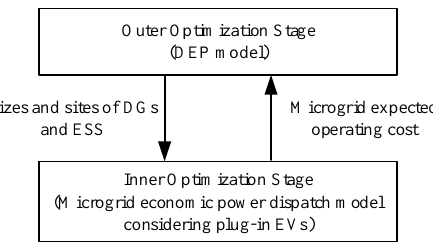
Figure 1. Two-stage modeling framework of the DEP problem.